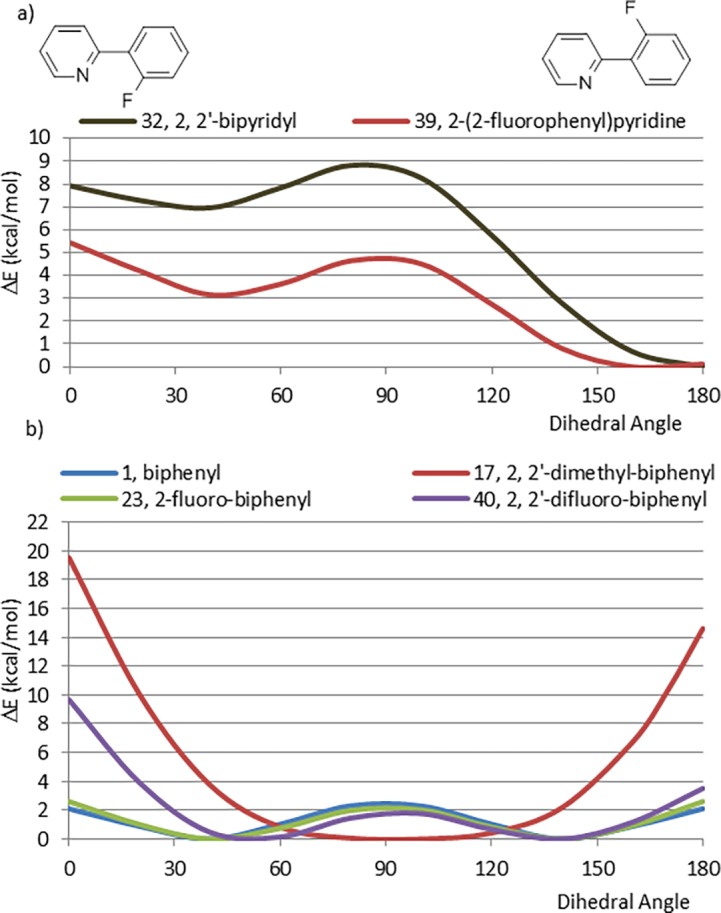
a) Comparison between 2, 2’-bipyridyl (32) and 2-(2-fluorophenyl)pyridine (39), b) Comparison of CEPs between biphenyl systems with and without methyl or fluorine atoms in ortho positions (1, 17, 23, 40).